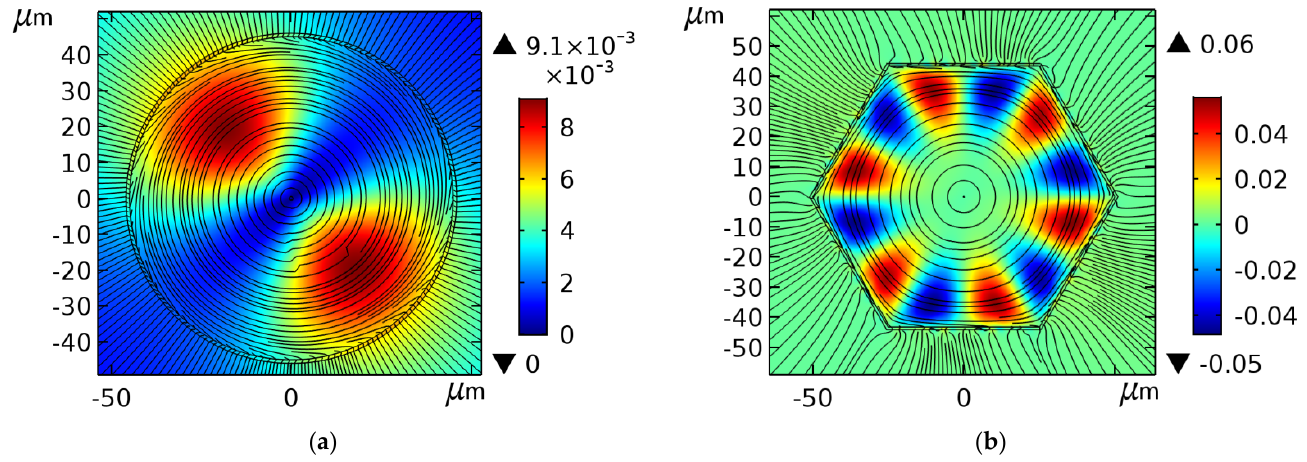
Figure 5. Radial projection of the transverse component of the Poynting vector of the fundamental air core mode at a wavelength of 3.39 µ m for: ( a ) a capillary with a wall thickness of 1 µ m (refractive index n = 1.45) with an air core diameter of D = 90 µ m; ( b ) hollow hexagon with a wall thickness of 1 µ m (refractive index n = 1.45). Black lines are streamlines of the transverse component of the Poynting vector of the fundamental air core mode. The effective mode areas are the same in both cases.